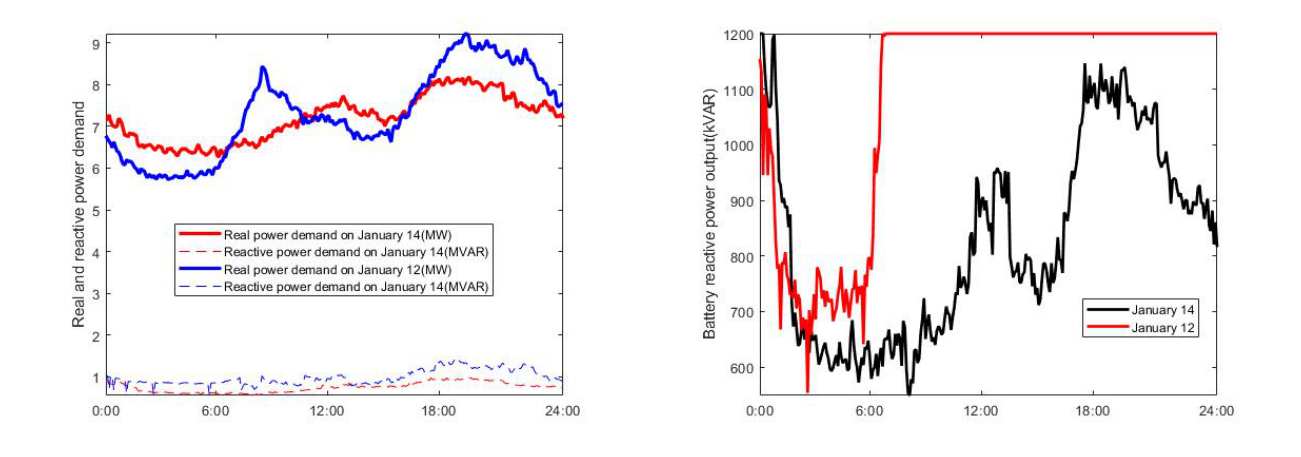
Figure 10. The impact of load level on voltage control